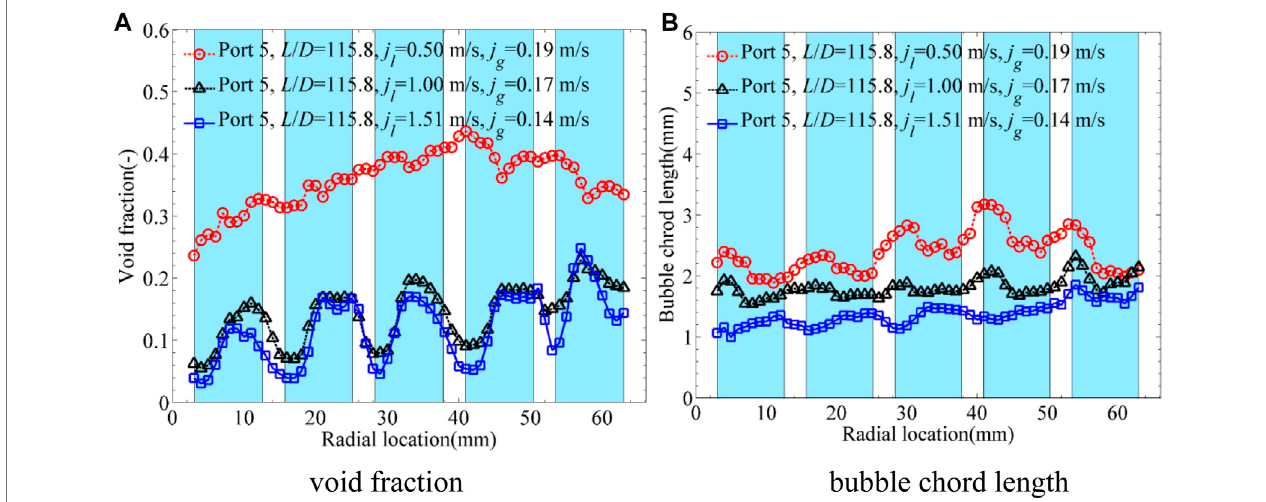
FIGURE 10 | In fl uence of MVSG on wall-peak phase distribution (Ren et al., 2018a). (A) Void fraction. (B) Bubble chord length.